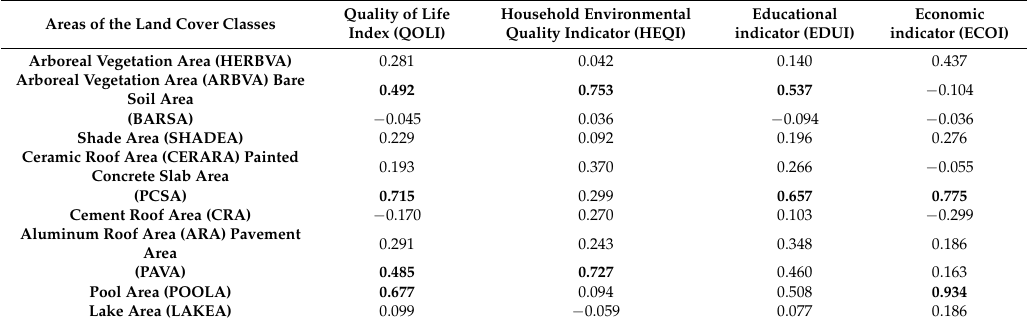
Table 3. Correlation matrix between the research indices/social indicators and land cover classes.